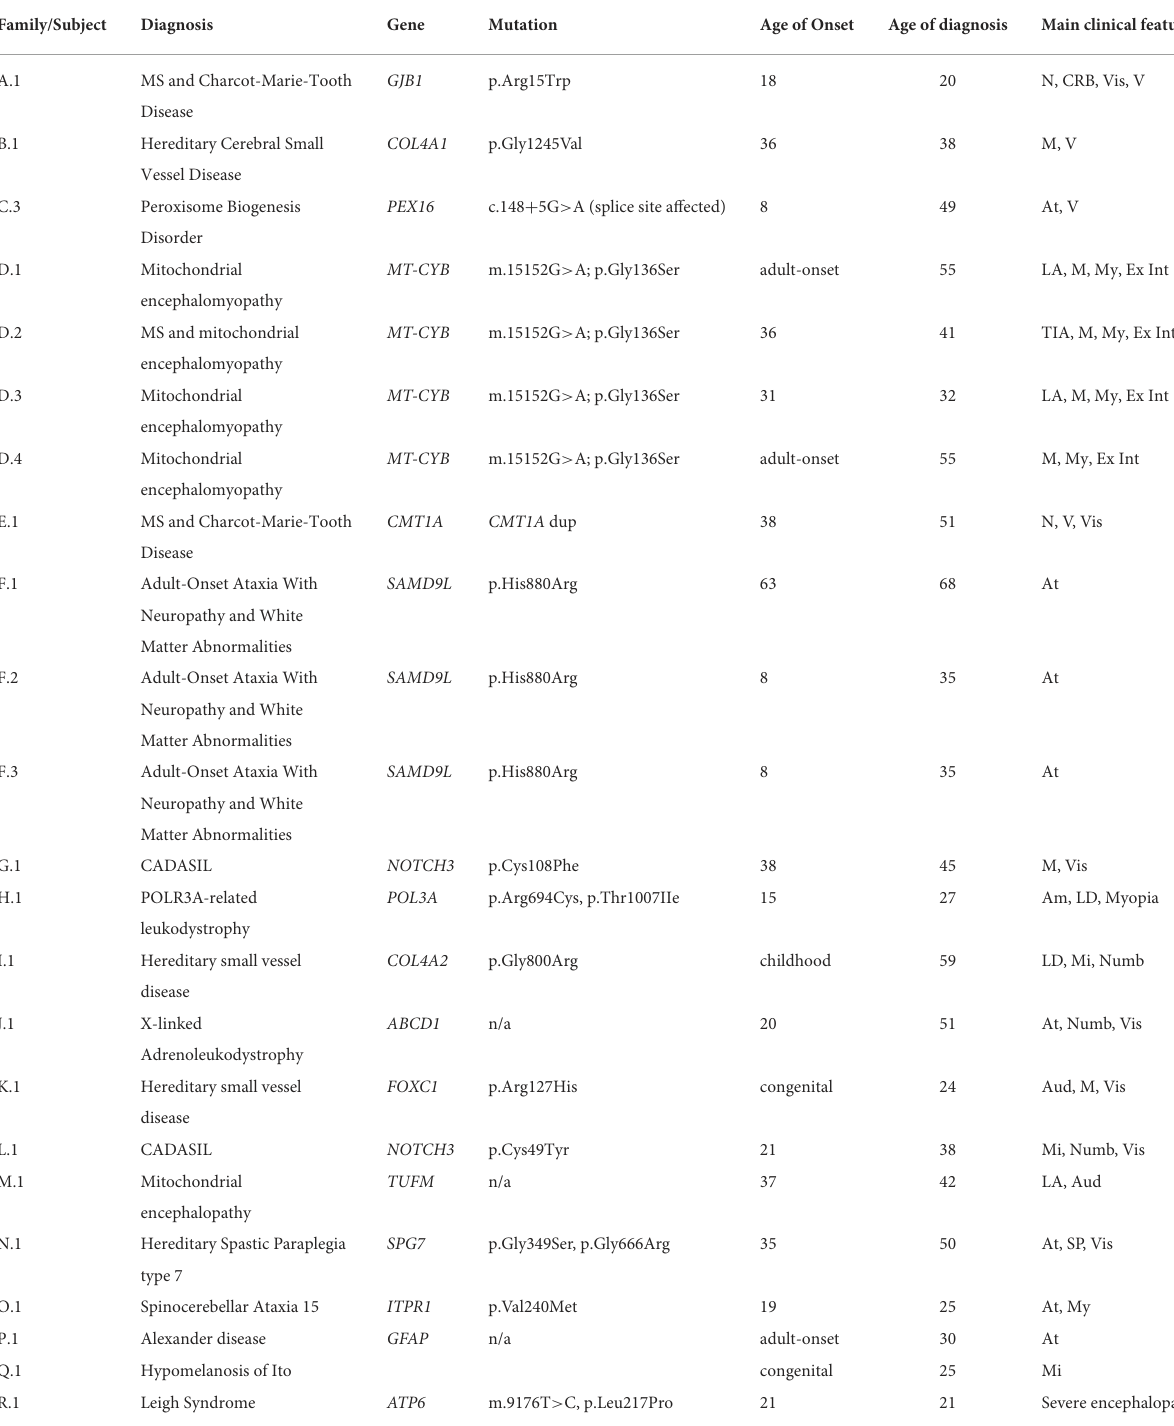
TABLE 3 Clinical and mutational characteristics of the 23 patients with a definite genetic